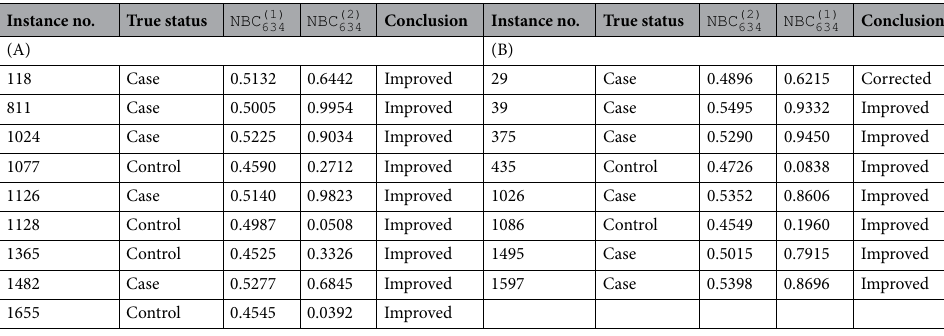
Table 1. Performance of remedying procedures for all possible situations of phs000634. (A) Results of using NBC (2) NBC (1) NBC (1) NBC (2) 634 to remedy 634 . (B) Results of using 634 to remedy 634 . The 3rd and 3th columns are (1) posterior probabilities of diagnosing instances as “positive” using the main model (i.e., NBC 634 for (A) and NBC (2) NBC (2) NBC (1) 634 for (B)) and the remedying model (i.e., 634 for (A) and 634 for (B)). Only an instance with posterior probability of being diagnosed as “positive” equaling from 0.45 to 0.55 is considered by remedying (2) procedures. Taking the 29th instance (case) for example, NBC 634 accepts “negative” because the posterior (1) probability of diagnosing it as “positive” equals 0.4896 (< 0.5 ) ; NBC 634 corrects the diagnosis with posterior probability of making correct diagnosis, 0.6215 (> 0.5 ) . In this situation, we label the conclusion as corrected . (2) NBC (1) For the 1655th instance (control), NBC 634 remedies 634 by improving the posterior probability of making correct diagnosis from 0.5455 ( = 1 − 0.4545 > 0.5 ) to 0.9608 ( = 1 − 0.0392 > 0.5455 ) . In this situation, the conclusion is labeled as improved . Other results can be explained